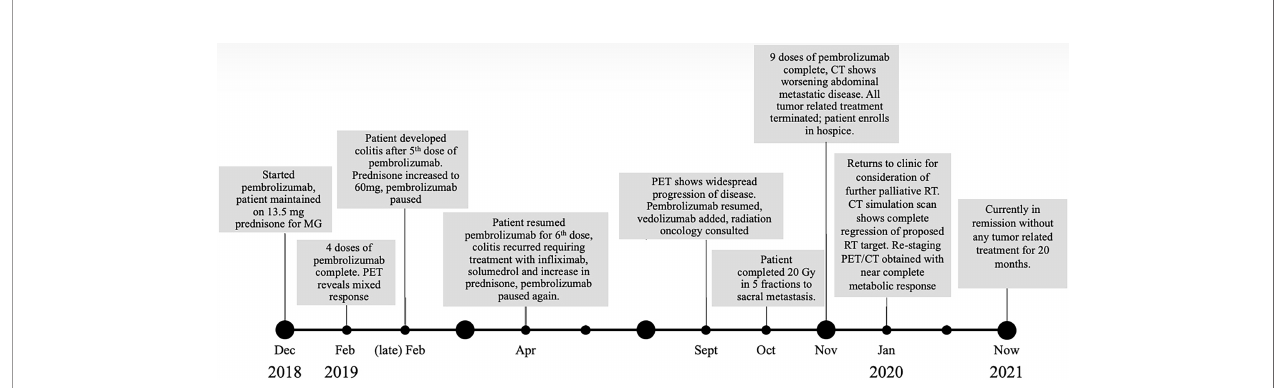
FIGURE 1 | Case timeline detailing therapeutic interventions and clinical